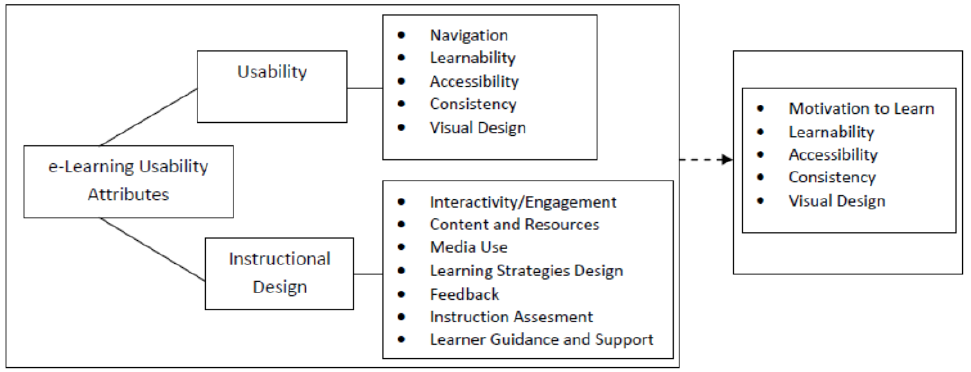
Figure 1 . E-Learning usability framework by Zaharias and Poylymenakou